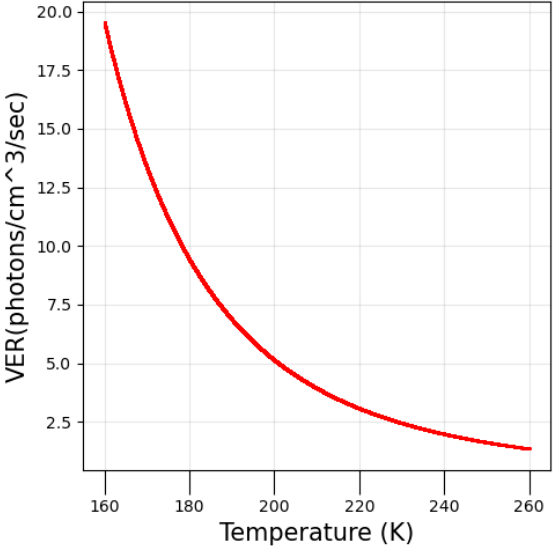
Figure 9. SABER VER (volume emission rate) 557.7 nm, which only depends on temperature (160–260 K) obtained at fixed atmospheric parameters (atomic oxygen concentration [ O ] = 3.7 · 10 11 , [ M ] = 6 · 10 15 , molecular oxygen concentration [ O ] = 1.3 · 10 15 ; used Formula (7) from [16]).